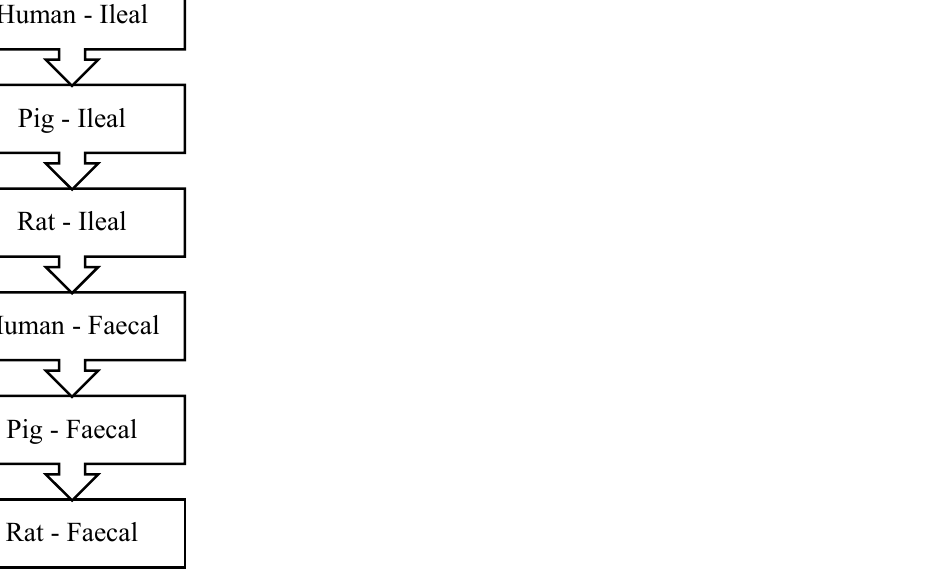
Figure 4. Ranking preference of digesta used for determination of protein quality. Redrawn from [63].